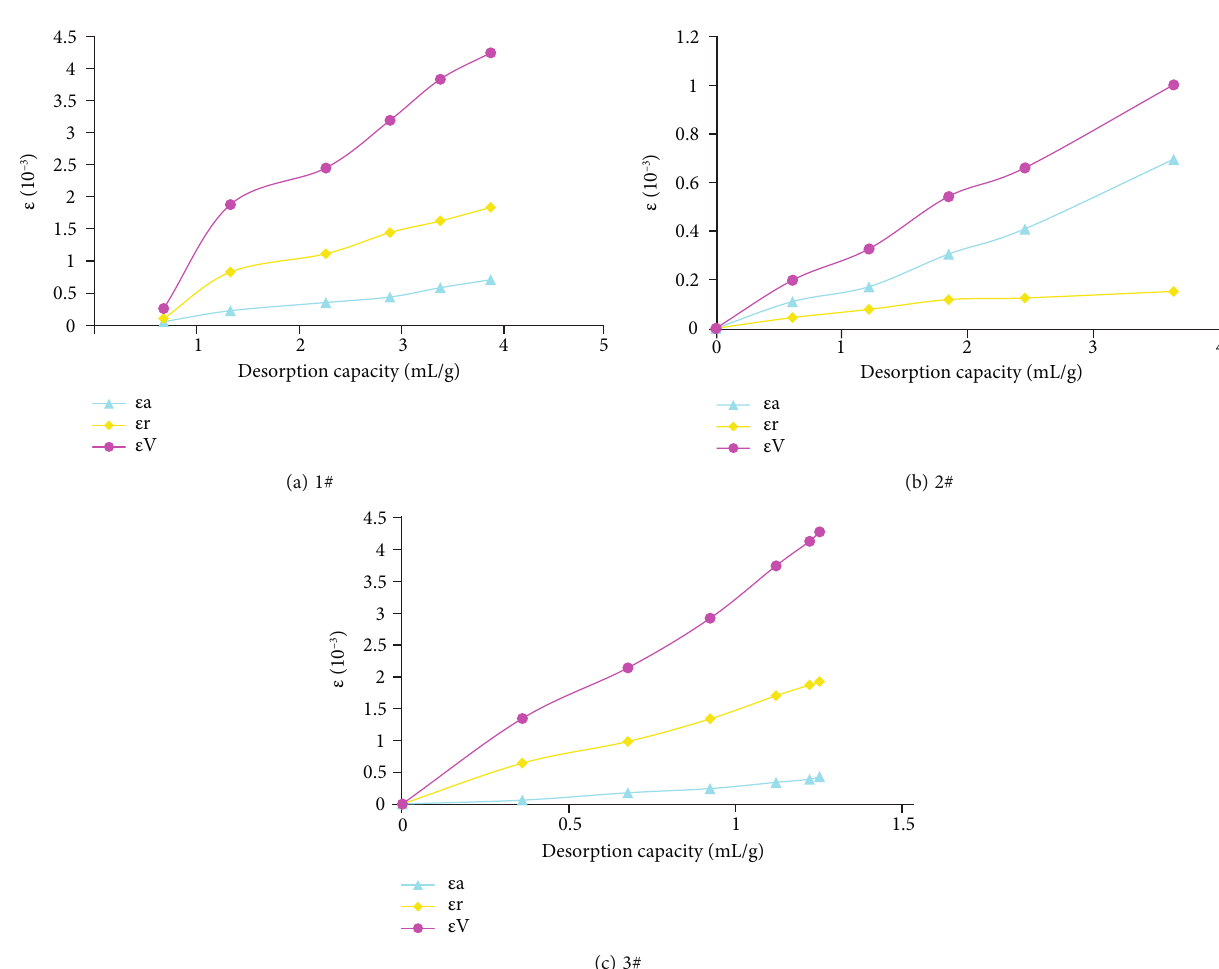
Figure 3: Relationship between desorption strain and desorption